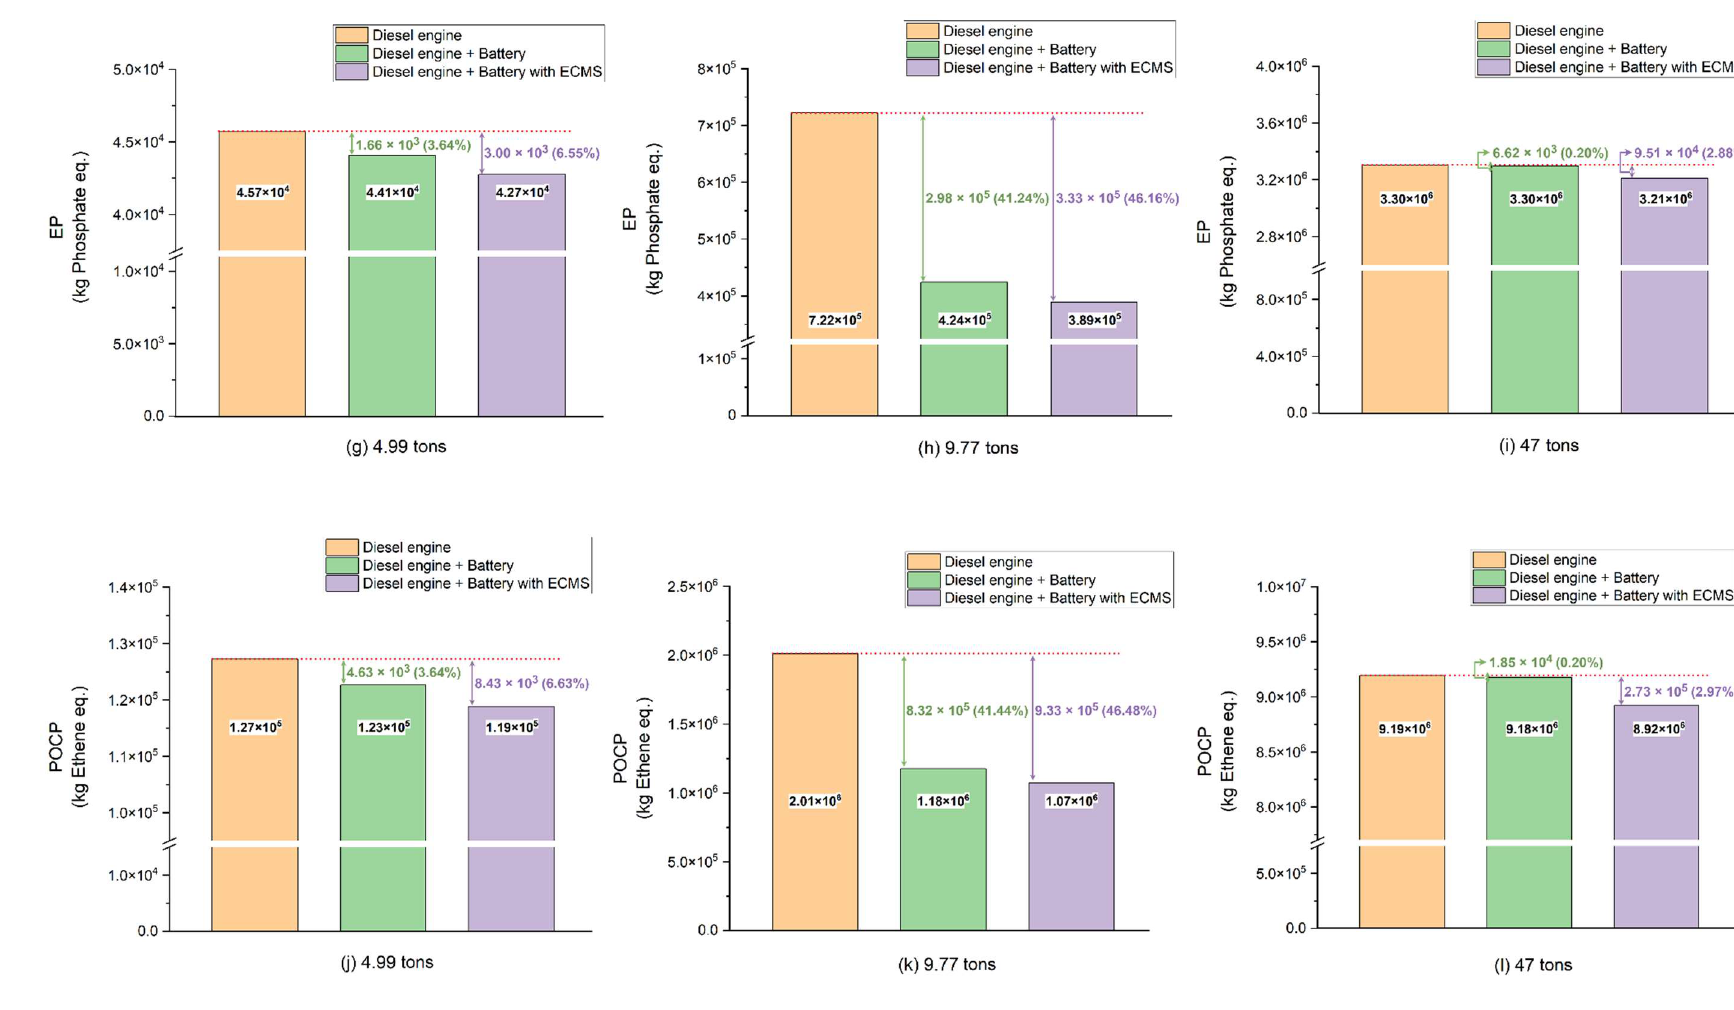
Figure 12. Environmental impacts during the lifespan of each ship.